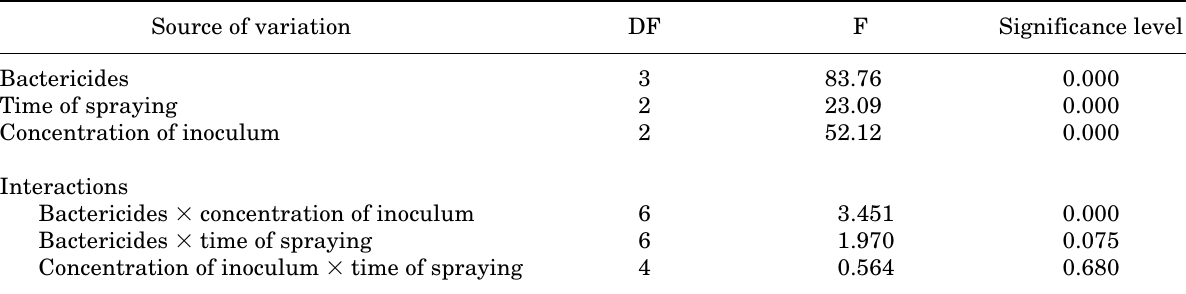
Table 2. Analysis of variance on chemical control of Fireblight in 1995.